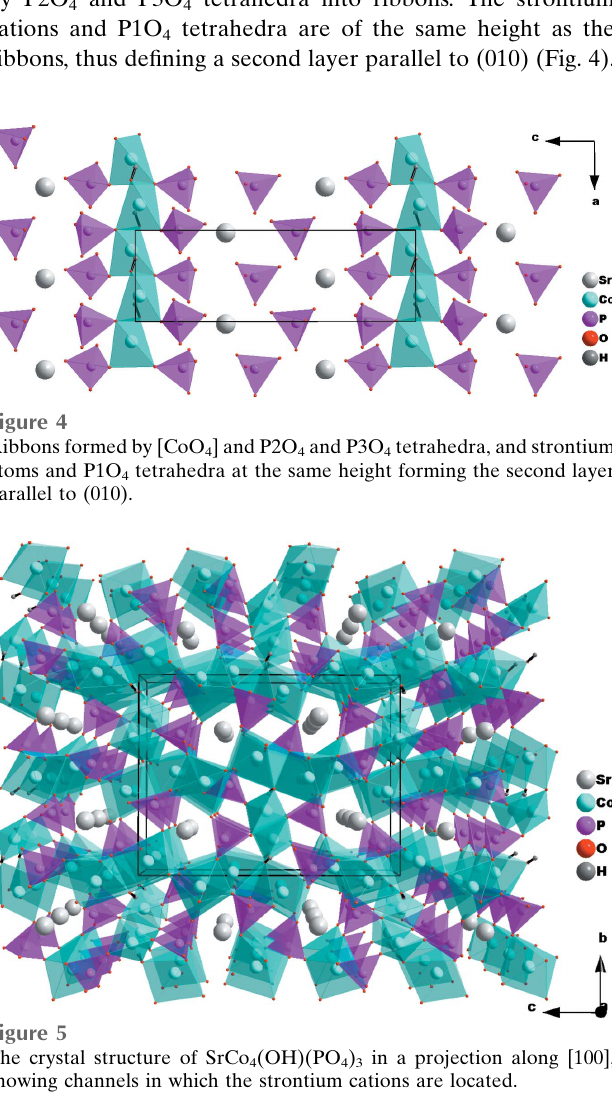
, (cid:5) z + 3 ; (ii) (cid:5) x (cid:5) 1 , (cid:5) y + 1, z + 1 ; (iii) 2 2 2 2